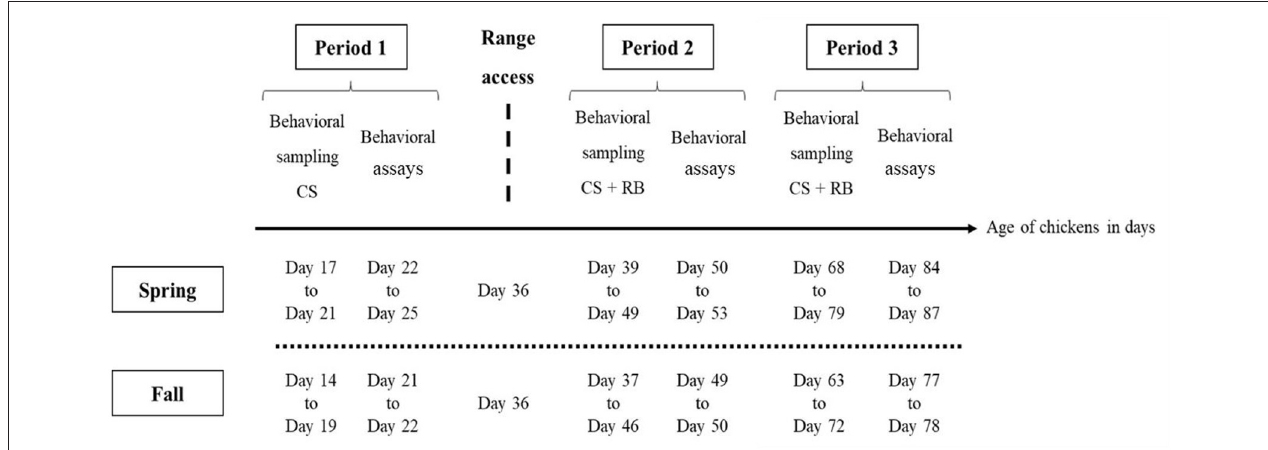
FIGURE 1 | Schedule of behavioral observations (Continuous sampling, CS), Ranging behavior measurements (RB), and behavioral assays (exploration and social motivation tests) carried out during the production cycle of free-range chickens. Period 1 comprises of 5 and 6 days of behavioral observations, and 4 and 2 days of behavioral assays, before range access, for spring and fall, respectively. Period 2 and 3 comprise each, 5 days of behavioral observations and ranging behavior measurements (scan sampling) and 4 and 2 days of behavioral tests, for spring and fall, respectively. Range access was given when chicken were 36